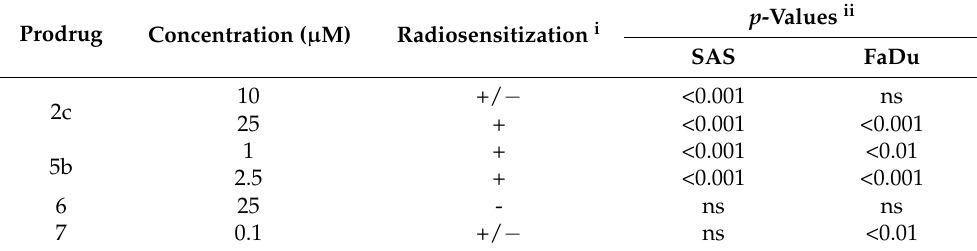
Table 3. Statistical comparison ( p -values) of irradiation dose–response curves with and without sub-toxic concentrations of the drug candidates.